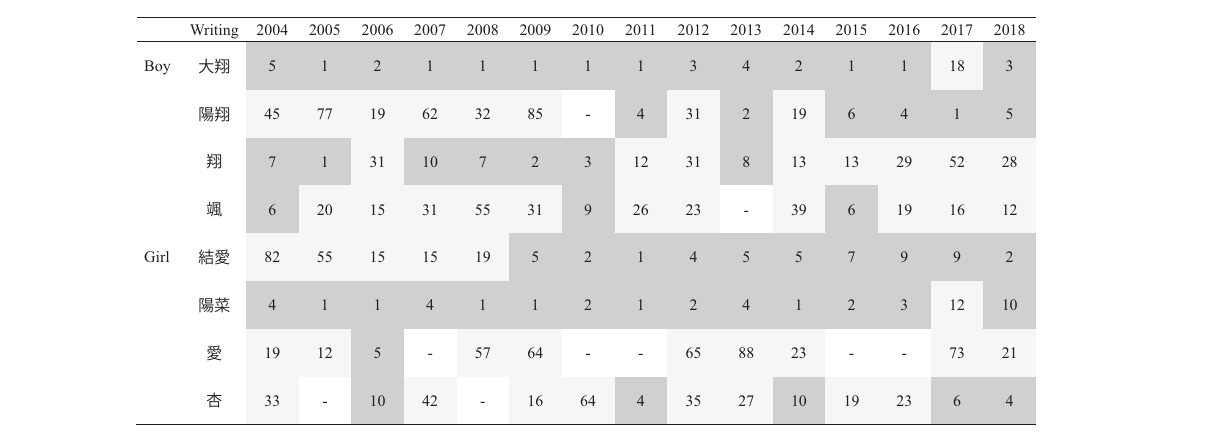
Table 1 Ranks among the top 100 most common writings of names in Japan, 2004 – 2018.